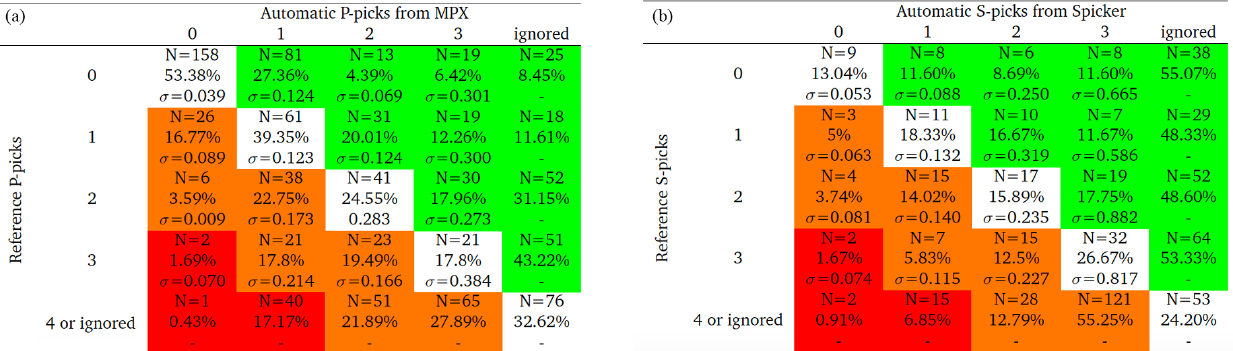
Table B3. Confusion matrices of P and S picks, comparing the automatic picks with reference picks. Columns are quality classes of the automatic P picks from MPX (a) and S picks from Spicker (b) , and rows represent the pick weighting classes provided by the human analyst for reference data. The parameters in each cell of the matrices are explained in the text.